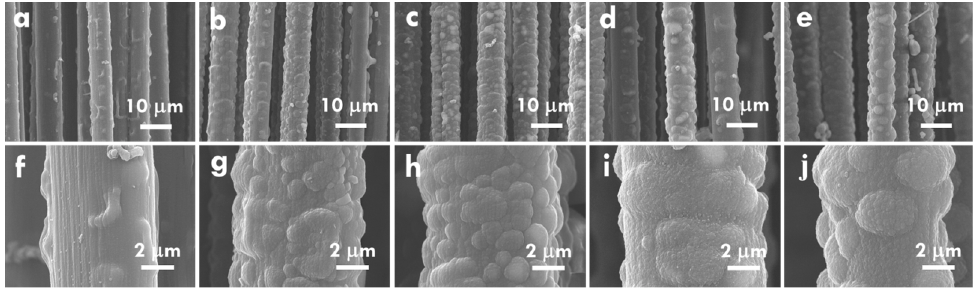
Figure 1. The SEM images for the CF@PPy prepared using the applied currents of ( a , f ) 10 mA, ( b , g ) 20 mA, ( c , h ) 30 mA, ( d , i ) 40 mA, and ( e , j ) 50 mA for 10 min in the 0.5 M pyrrole and 0.3 M NaClO 4 electrolyte.